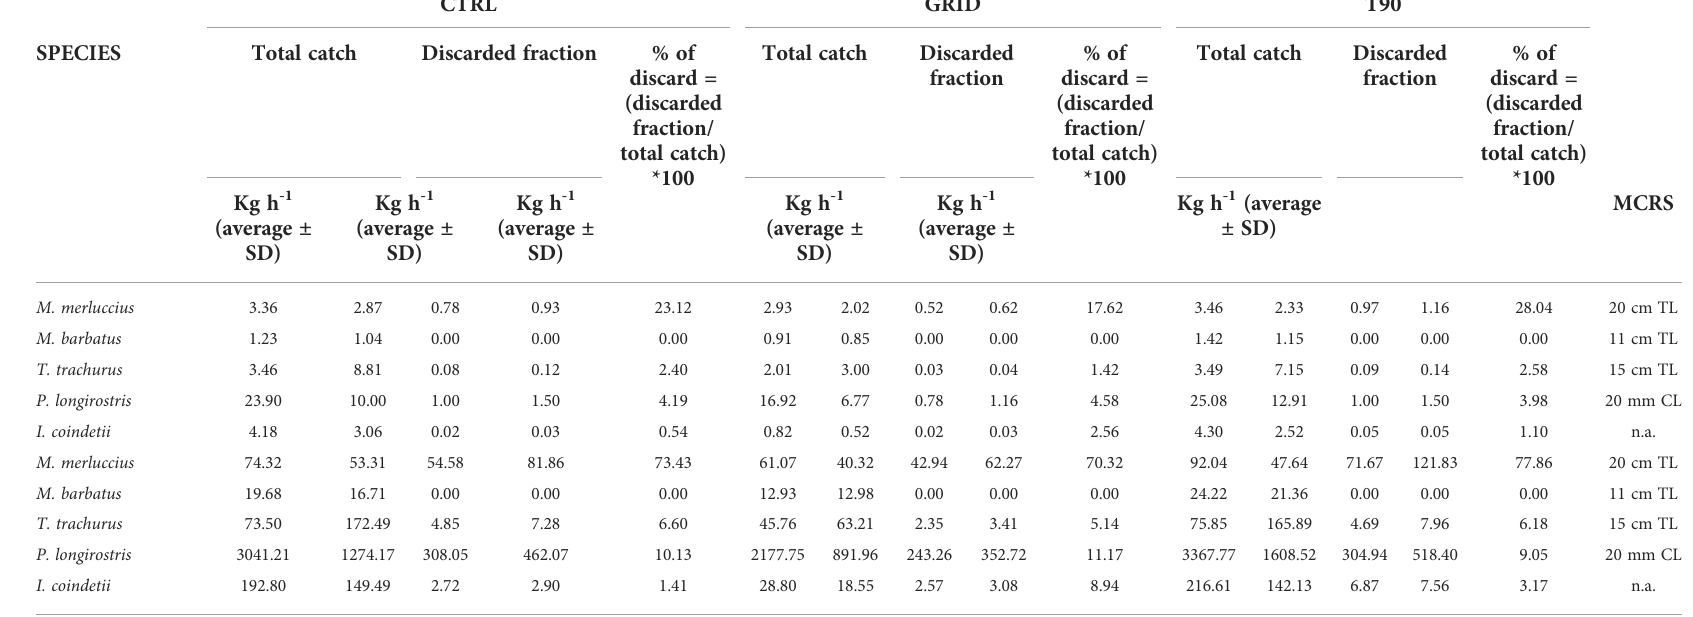
TABLE 1 Mean (± SD) biomass (kg h -1 ) and abundance (n h -1 ) indices of the total catch and discarded fraction of the target